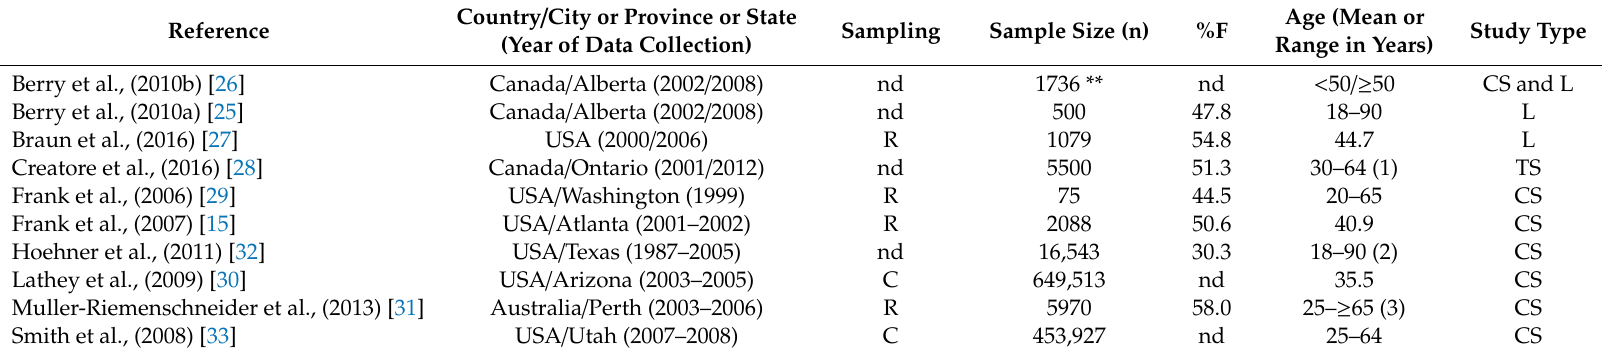
Table 1. Descriptive characteristics of the reviewed studies (n = 10).